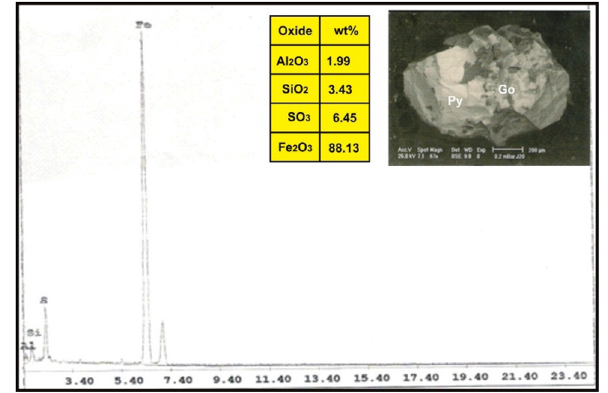
Figure 19: ESEM - EDX analysis of pyrite ( Py ) replaced by goethite ( Go ) in dolerite dike at Wadi